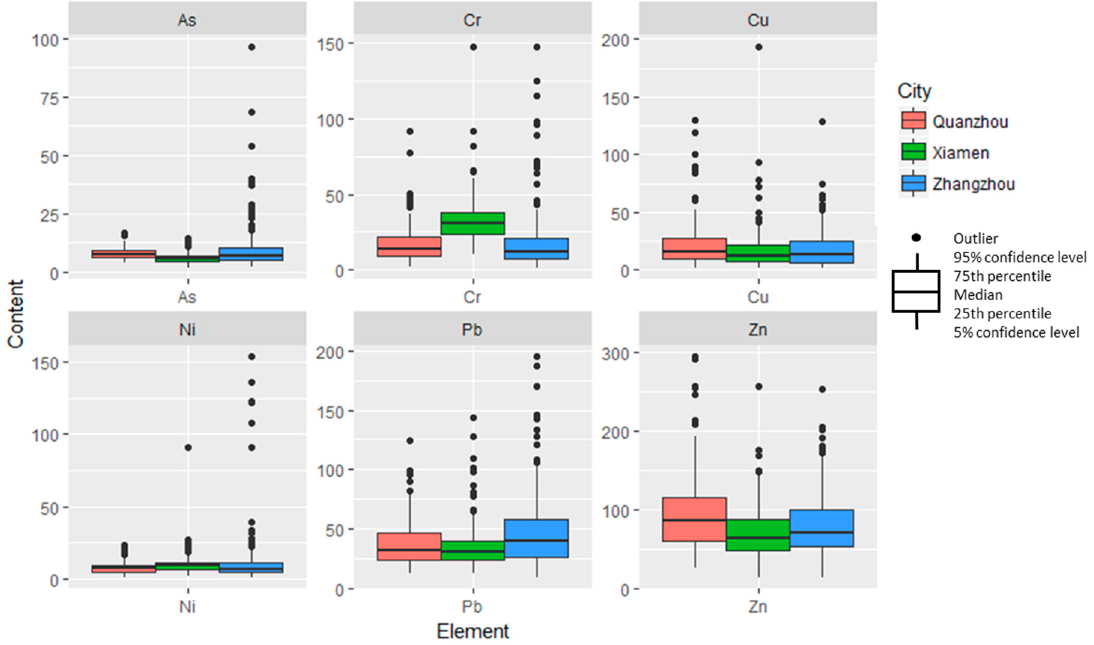
Figure 2. Heavy metal concentrations in the soils of Quanzhou, Xiamen, and Zhangzhou.